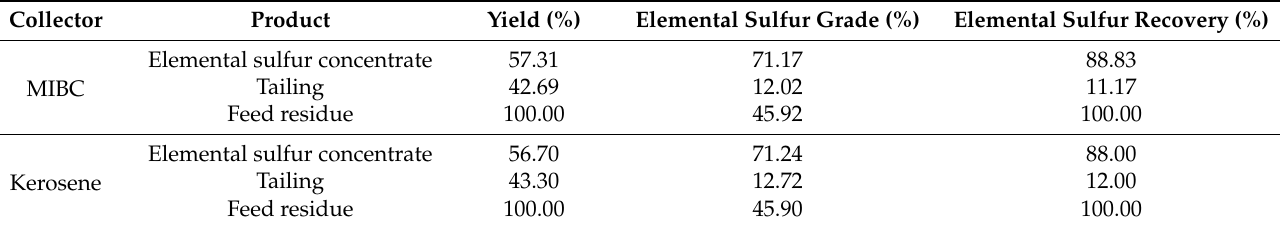
Figure 1. The flotation sheets of high-sulfur residue with MIBC ( a ) and kerosene ( b ). Table 5. The flotation results of high-sulfur residue with MIBC and kerosene.